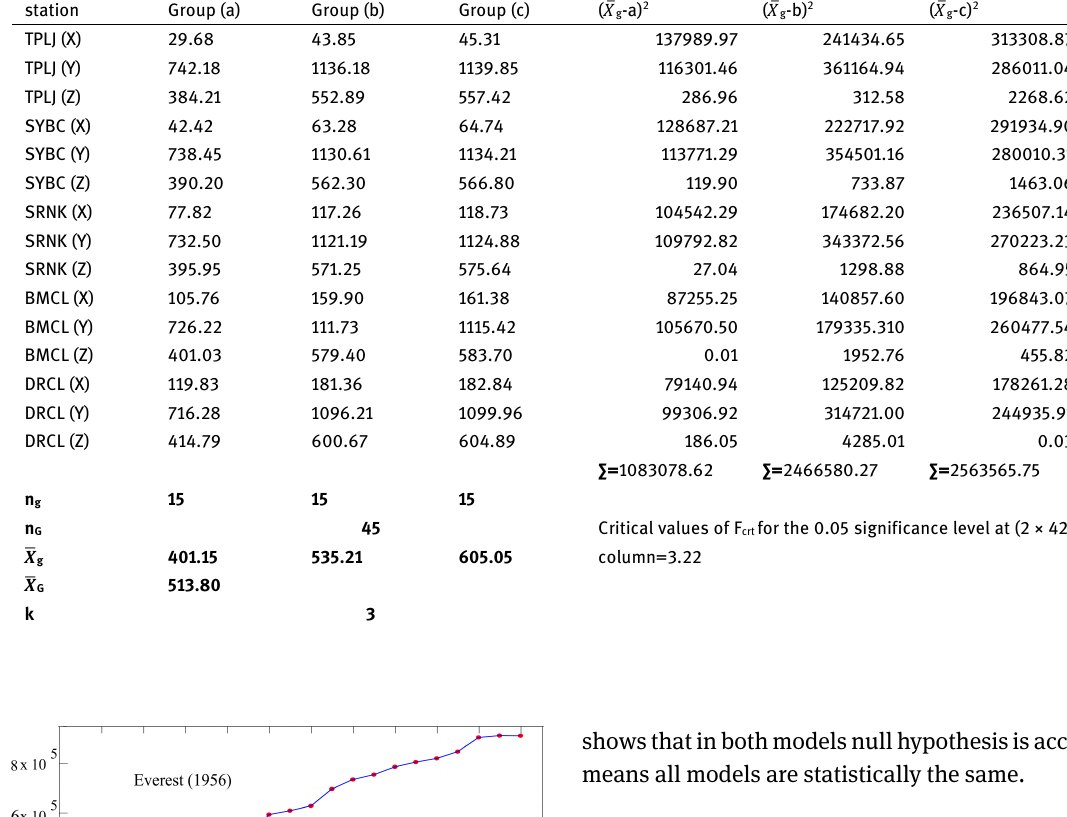
shows that in both models null hypothesis is accepted that means all models are statistically the